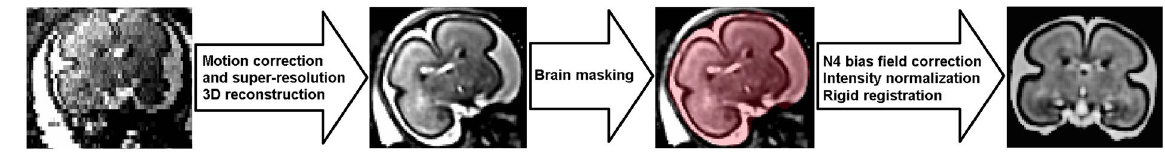
Figure 1. The preprocessing steps in fetal brain MRI analysis: (a) shows the out-of-plane view (coronal view) of an original axial T2wSSFSE scan, (b) is the volumetric image obtained from iterations of inter-slice motion correction and robust super-resolution volume reconstruction 38 , (c) shows the brain mask obtained through supervised levelset segmentation and manual refinement, and (d) is the reconstructed image, reoriented and co- registered to the common atlas coordinate space after N4 bias field correction and intensity